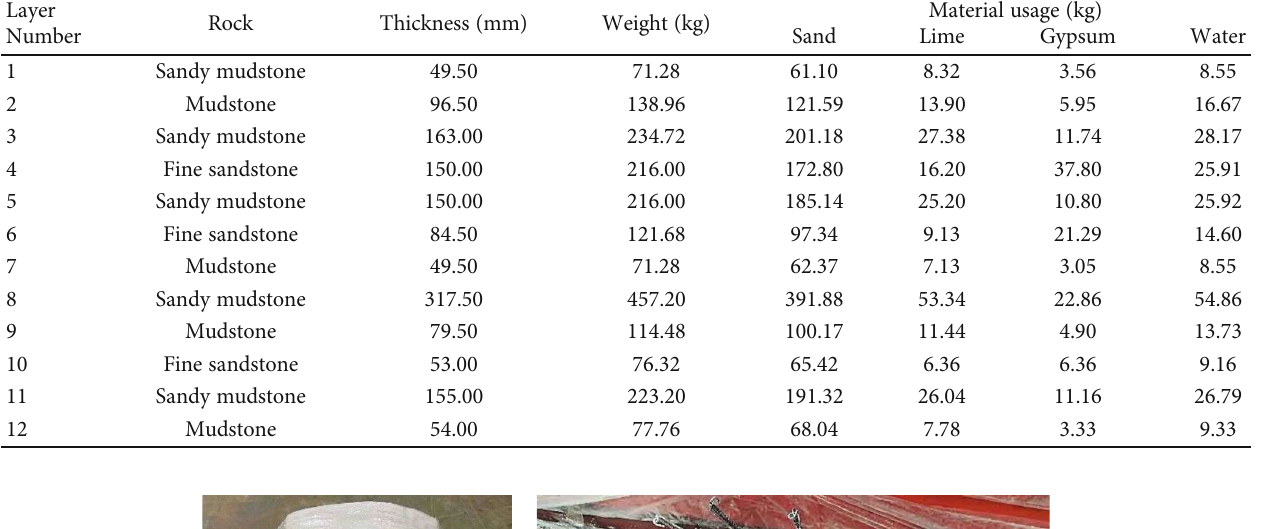
Table 1: Test model similar material ratio table.